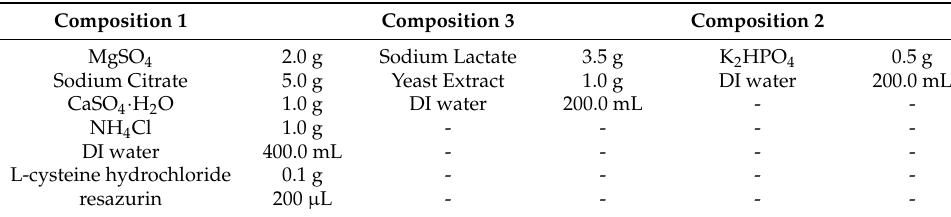
Table 1. Composition of ATCC 1249 medium.